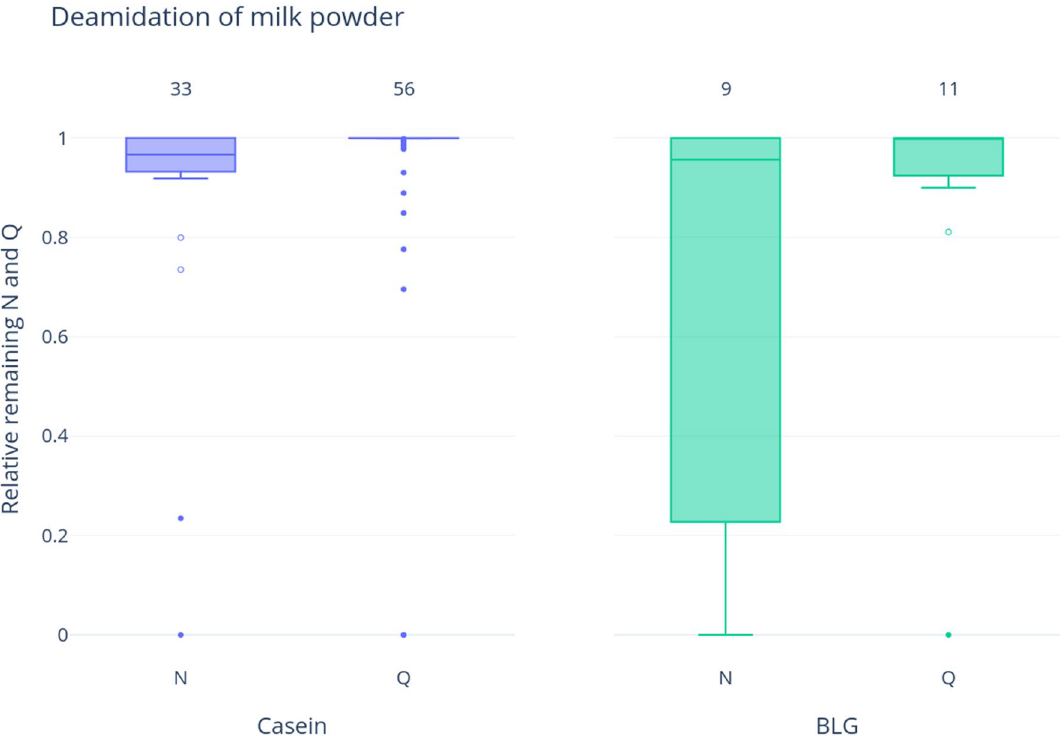
Figure 1. Deamidation of any casein and BLG proteins in milk powder samples. Numbers at the top of the bars show the number of deamidating amino acids (i.e., asparagine and glutamine combined) represented by this result. The y-axis represents the relative remaining amount of the deamidating amino acid—therefore high values represent less deamidation; whereas low values imply higher levels of deamidation. Outliers are shown as points, while suspected outliers are shown as hollow